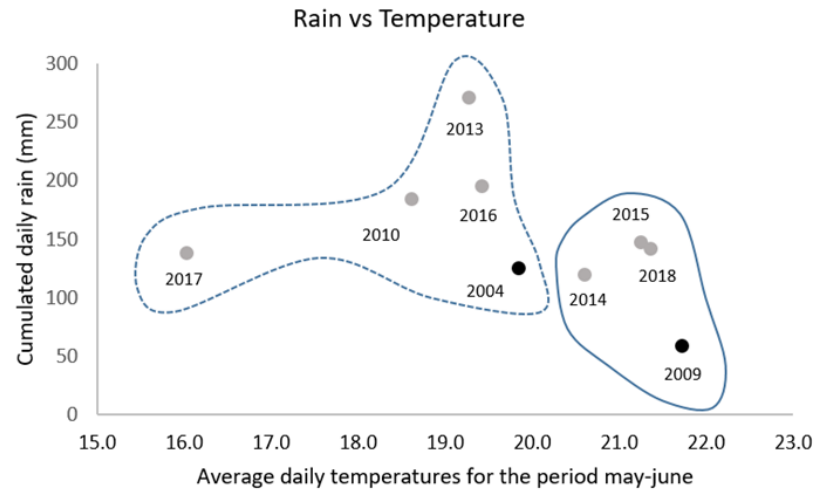
Figure 5. Average daily temperature versus cumulated rain recorded during the period May–June for nine different years. Dashed line identifies years with high correlation; continuous line identifies years with low correlation. Black dots represent years reported in Figure 4.